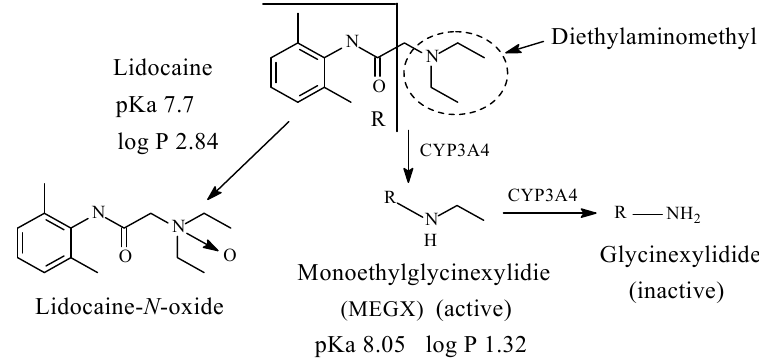
Figure 32. Major metabolic pathways of lidocaine.